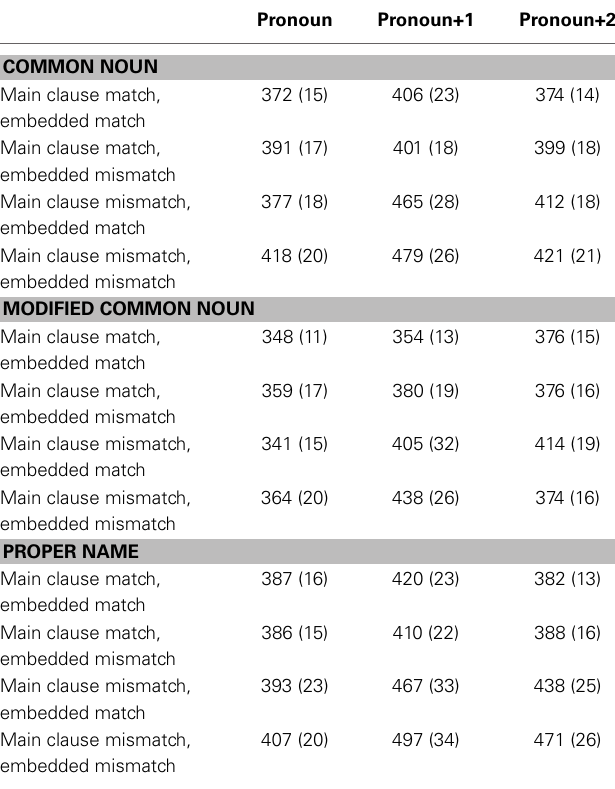
Table 2 | Grand average reading times (with standard deviations) in each ROI across all conditions in Experiment